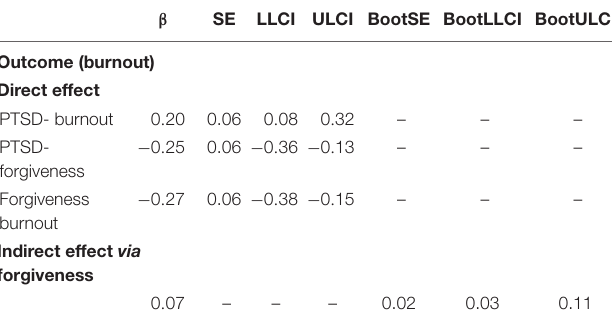
TABLE 3 | PROCESS results of mediation effect of PTSD on burnout with work-related factors as